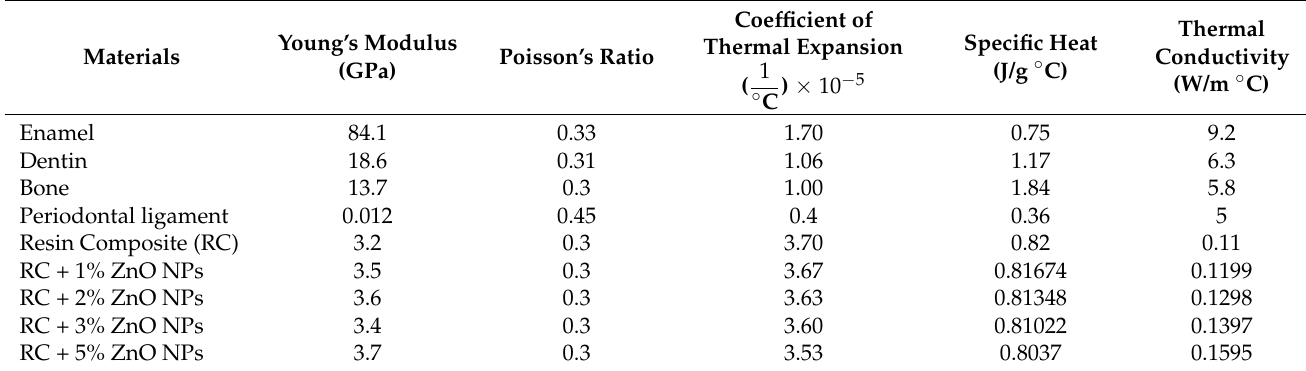
Table 1. Thermal and mechanical properties of the structures and materials used for simulating the finite element